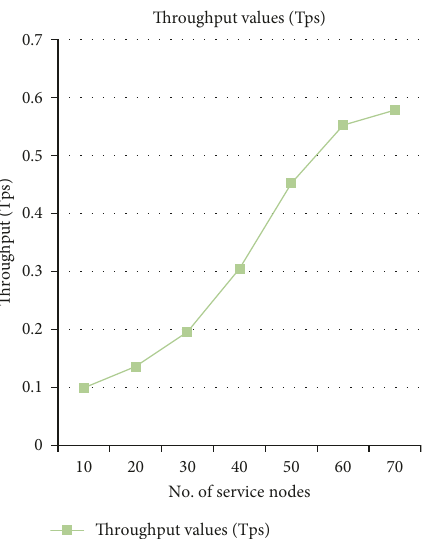
Figure 8: Selection precision based on the feedback effect.